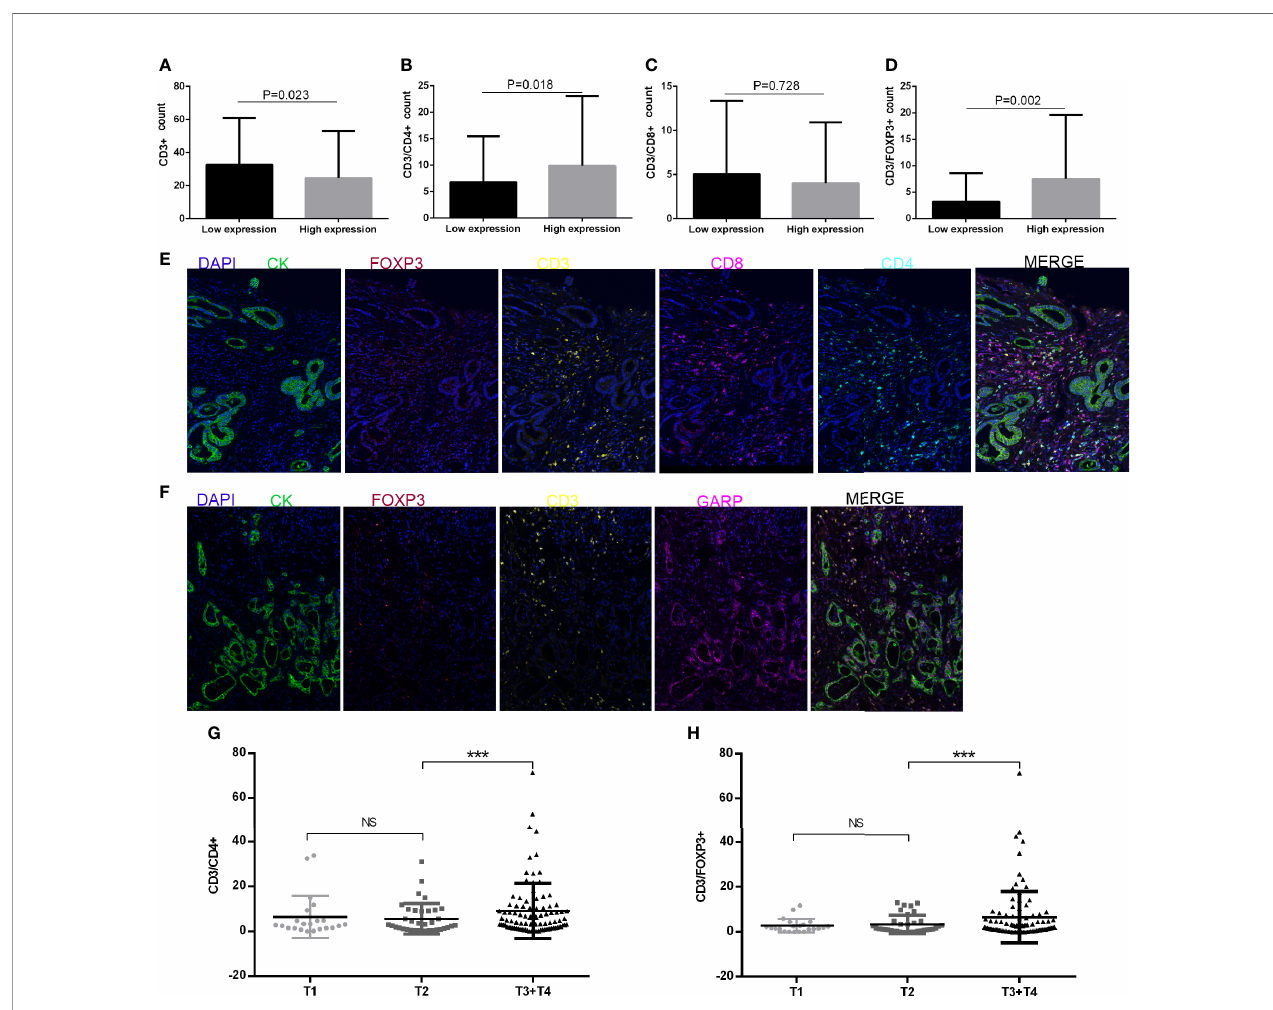
FIGURE 3 | (A – D) CD3+ T cell, CD4+ T cell, CD8+ T cell, and FOXP3+ regulatory T cell (Treg) in fi ltration levels in patients with low or high glycoprotein A repetitions predominant (GARP) expression. (E, F) Representative fl uorescence-based multiplex immunohistochemistry images. (E) A staining panel was developed to visualize CD3, CD4, CD8, FOXP3, and CK simultaneously on the same tissue slide. (F) A staining panel was developed to visualize CD3, GARP, FOXP3, and CK simultaneously on the same tissue slide. (G, H) Tumor size (T) was associated with changes in CD4+ T cell and FOXP3+ Treg in fi ltration. Ns, P > 0.05; ***, P <